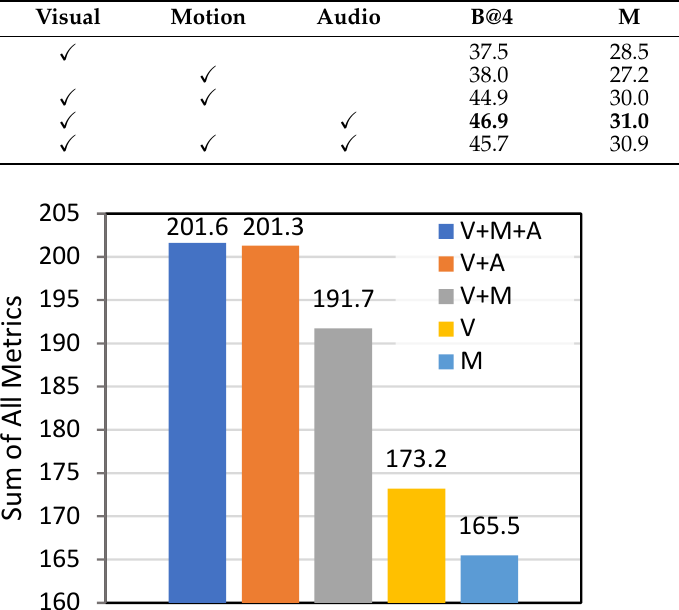
Figure 4. Ablation study of modalities on MSR-VTT dataset, using the sum of all metrics as overall metric. A larger value is